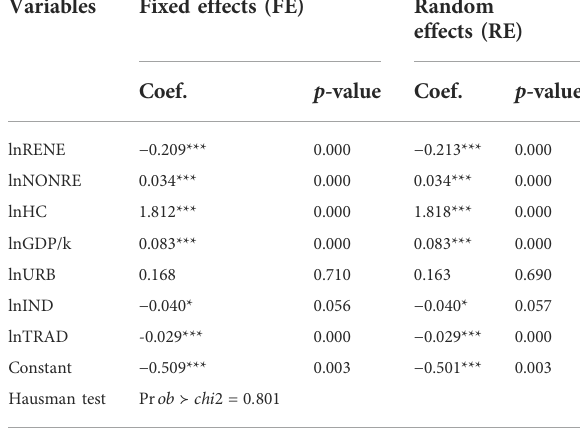
TABLE 11 Results of the linear model using the FE and RE estimators. Variables Fixed effects (FE) Random